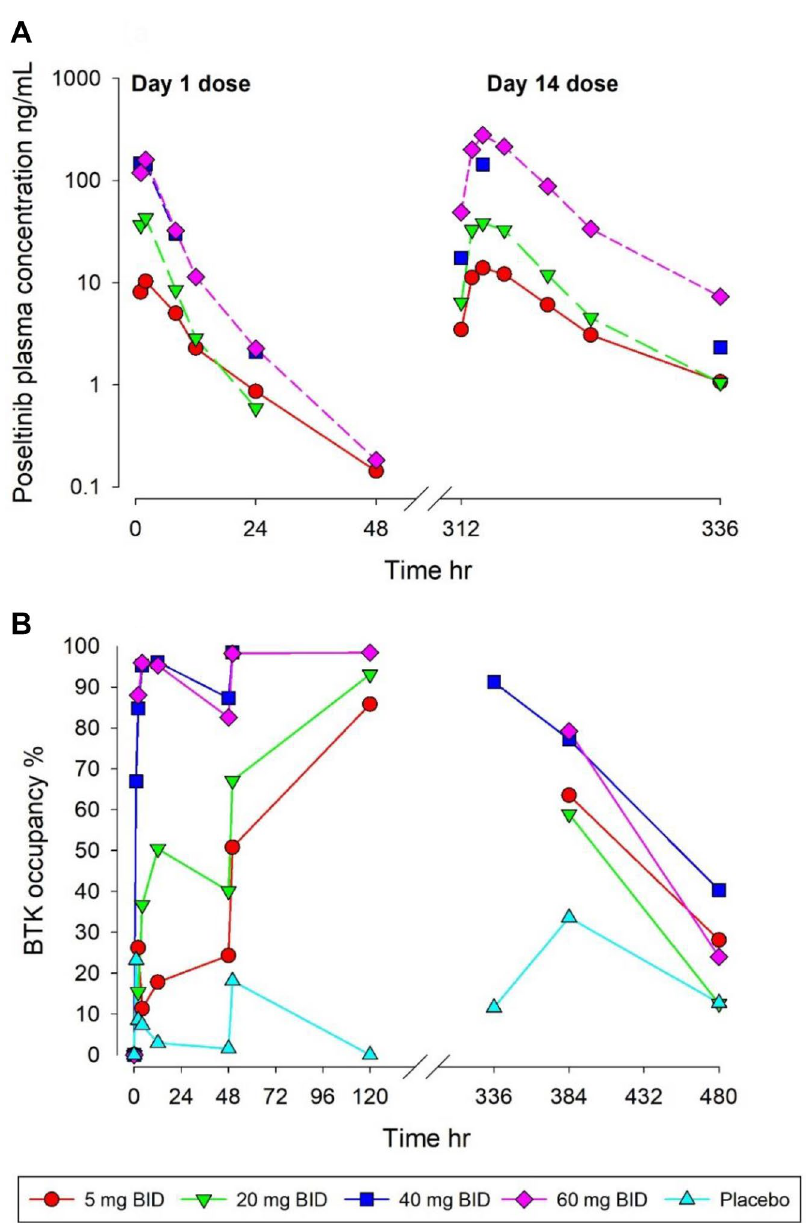
Figure 6. PK/PD relationship of poseltinib in healthy volunteers. ( A ) Healthy volunteers were administered for 5, 20, 40, or 60 mg/kg poseltinib twice a day (BID). Whole blood was collected 0, 1, 2, 8, 12, 24, and 48 h after drug administration for PK analysis. The data are shown as the mean ± S.D. ( B ) BTK occupancy (%) by measuring free BTK from human PBMC lysate was measured by ELISA at the indicated times. Each dot indicates an individual subject, and the lines on the dot plots indicate the mean values. Data from 18 of the 24 subjects from the healthy donor study, excluding 6 participants who were administered placebo, are